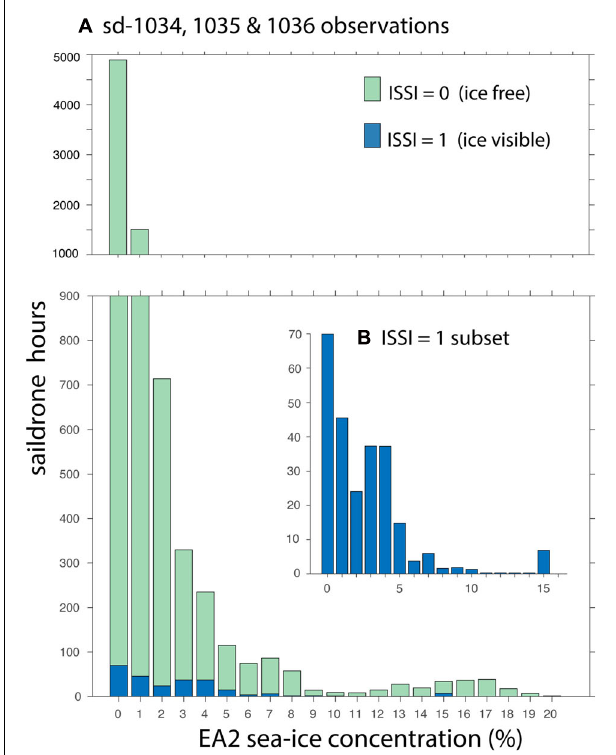
FIGURE 5 | (A) Histogram showing the number of hours saildrones spent in different EA2 sea-ice concentration levels. Data are from sd-1034, sd-1035, and sd-1036 and binned in 1% intervals over the period 5 June 2019 – 30 September 2019. (B) The inset histogram highlights the subset of observations collected when ISSI = 1, meaning sea ice was visible in the images taken from the